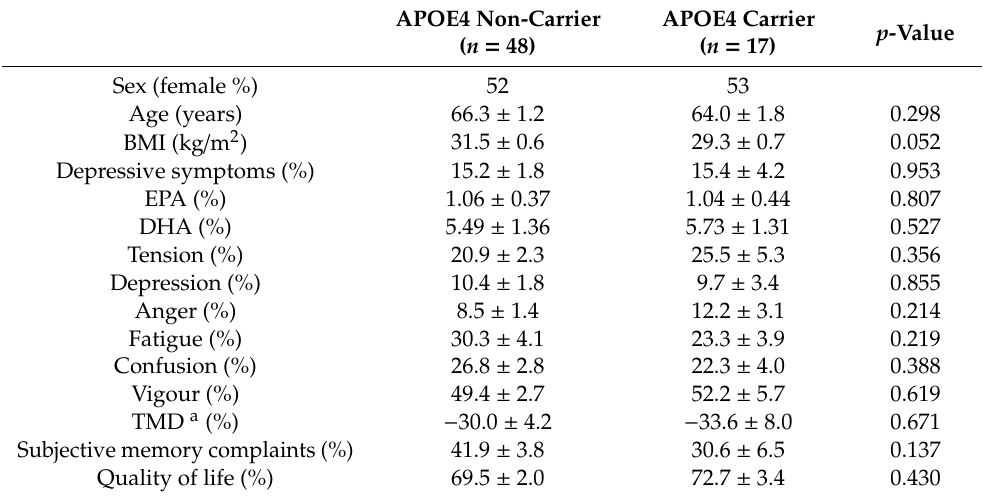
Table 3. Baseline demographics and wellbeing measures in APOE4 carriers vs.